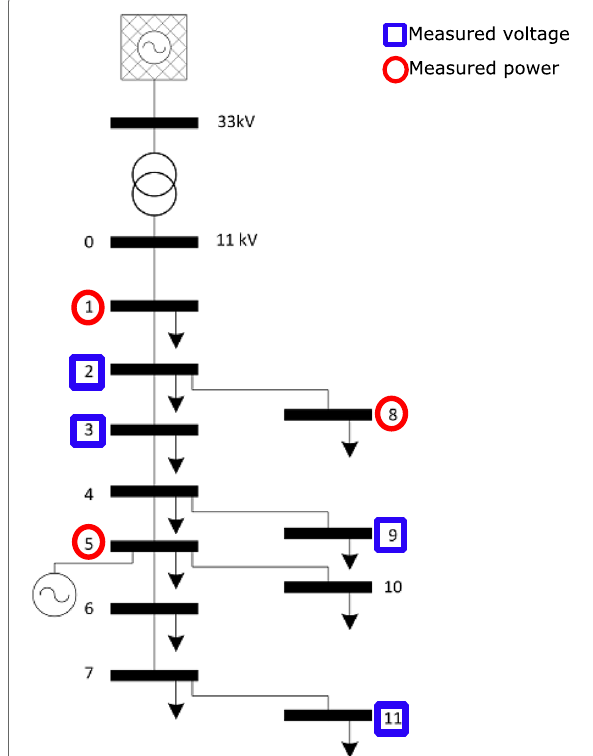
Fig. 2 UK generic distribution system (UKGDS) grid used for testing the NLO with the proposed ARMA